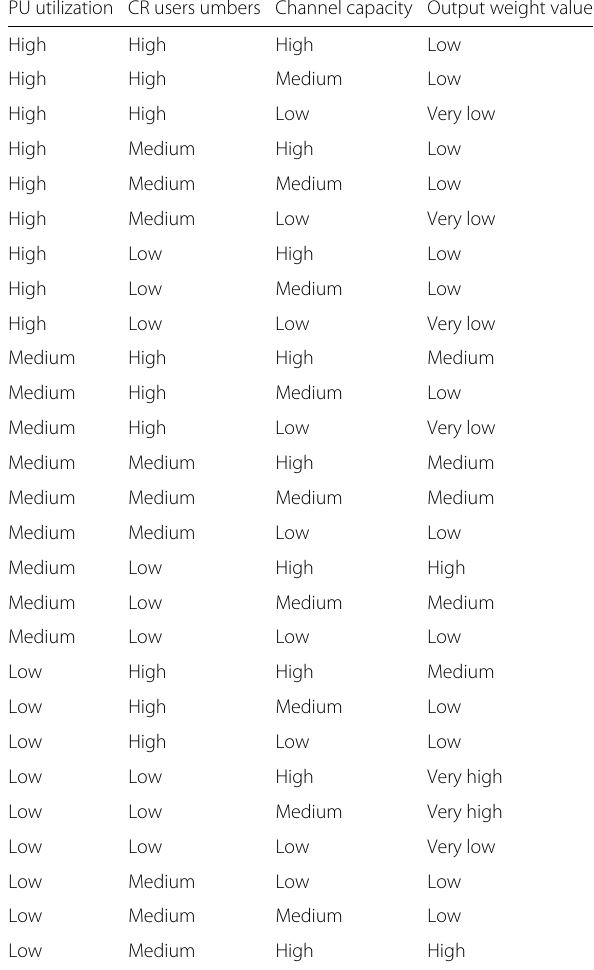
Table 3 Fuzzy base rule set